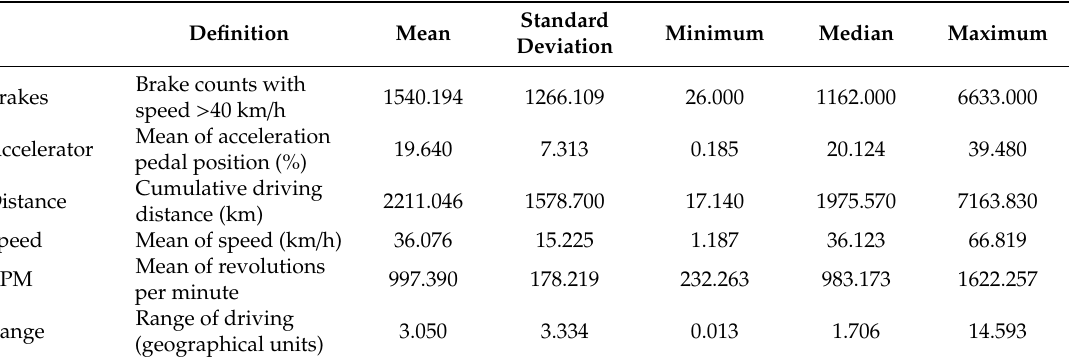
Table 2. Summary statistics of the 253 data files * .